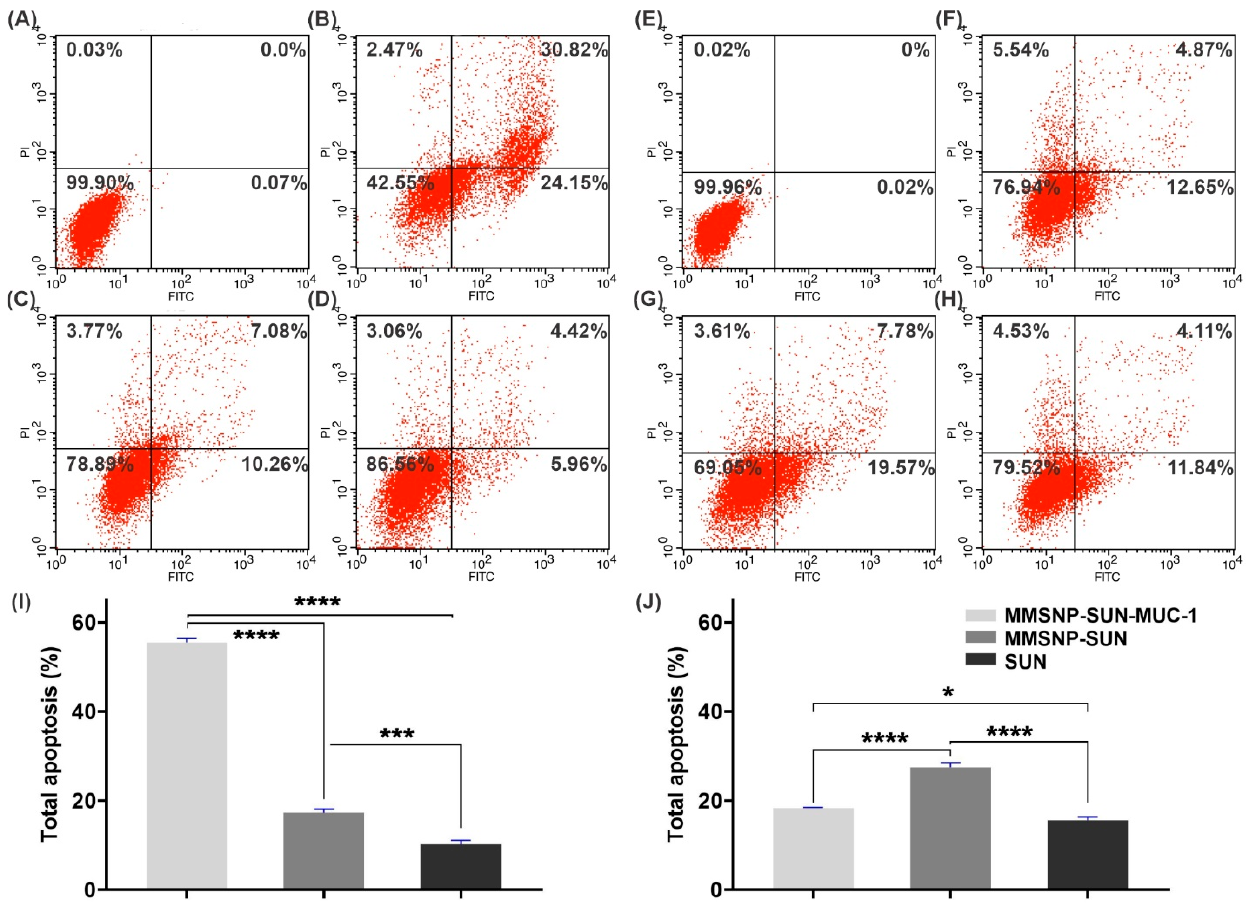
Figure 4. Apoptosis and necrosis evaluation. Annexin V/FITC and PI flow cytometric detection of apoptosis and necrosis in OVCAR-3 cells and MDA-MB-231 cells, respectively treated with normal media as control ( A , E ), MMSNP-SUN-MUC-1 ( B , F ), MMSNP-SUN ( C , G ) SUN ( D , H ) after 24 h. The histogram of total apoptosis data in OVCAR-3 cells and MDA-MB-231 cells sequentially ( I , J ). Data are shown as mean ± SD. The asterisks represent the following level of significance; not significant * p ≤ 0.05, *** p ≤ 0.001, **** p ≤ 0.0001.